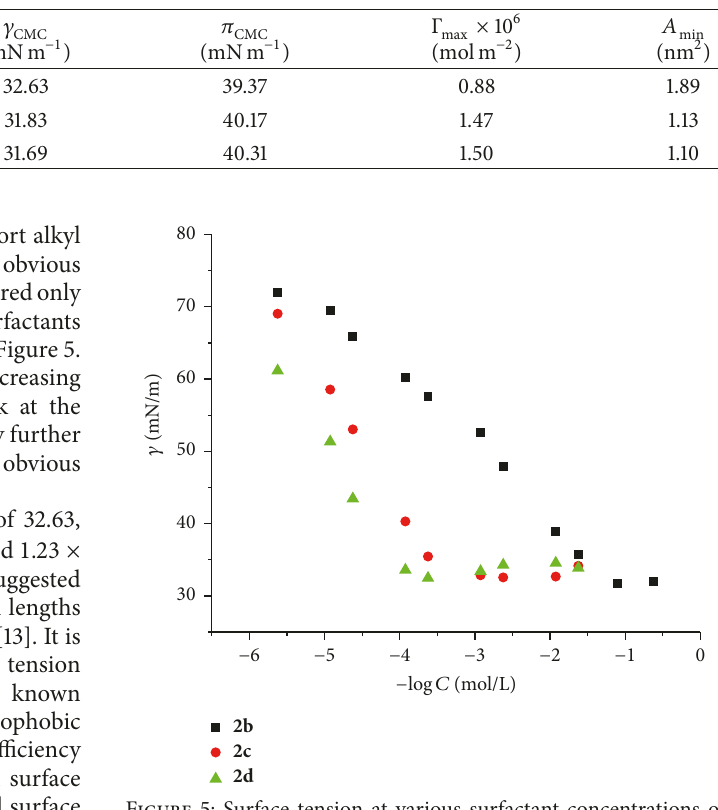
Table 1: Surface properties of three surfactants 2b – 2d .